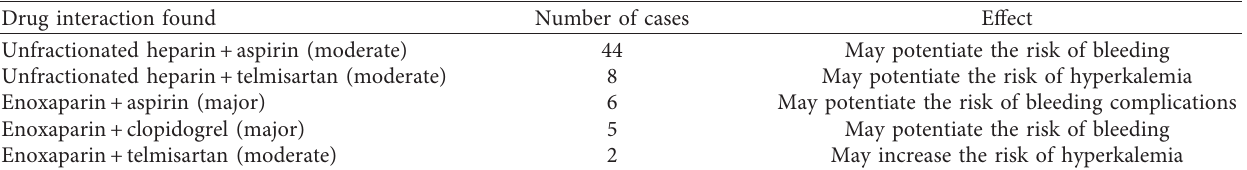
Table 5: Potential drug-drug interactions ( n �